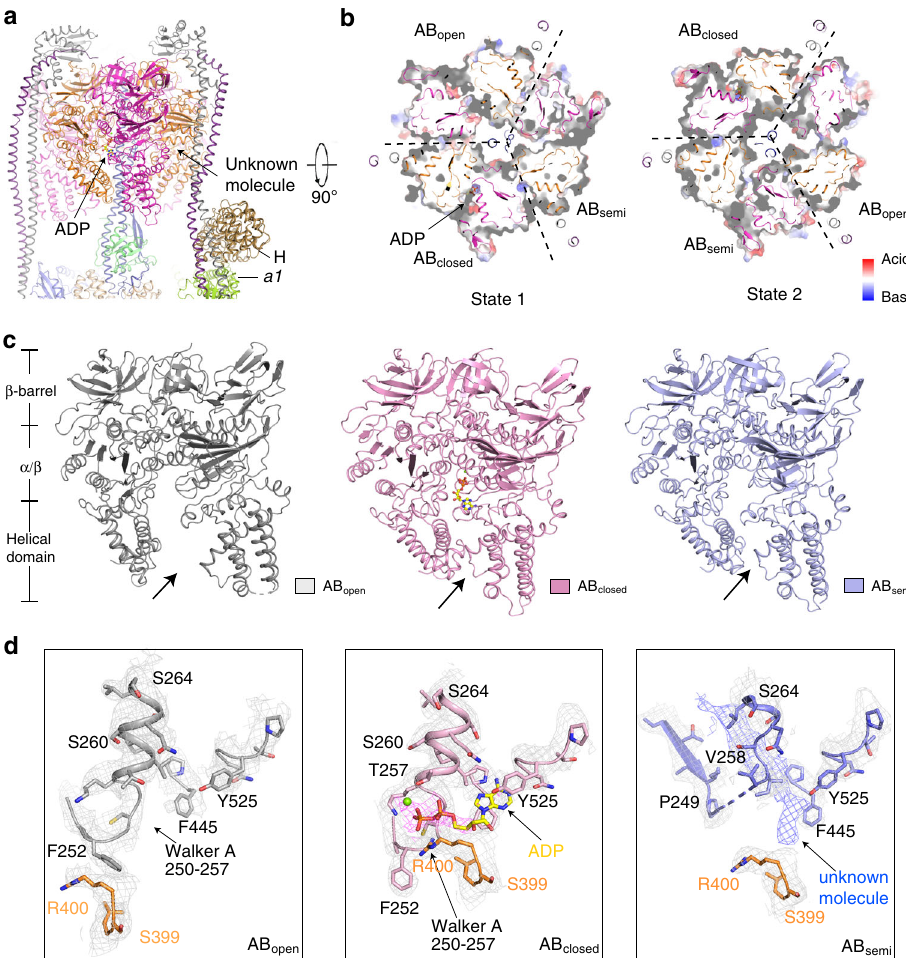
Fig. 2 Structure of the V1 domain showing three AB heterodimers with distinct conformations. a Overall structure showing the V1 domain. b The cytosolic view of the V1 domain in state 1 (left) and state 2 (right). c , d The structural comparison of AB open , AB closed , and AB semi in state 1. The domains of the AB heterodimer have been indicated in the left side of panel c . Cryo-EM maps in state 1 are shown at the 4 σ level.